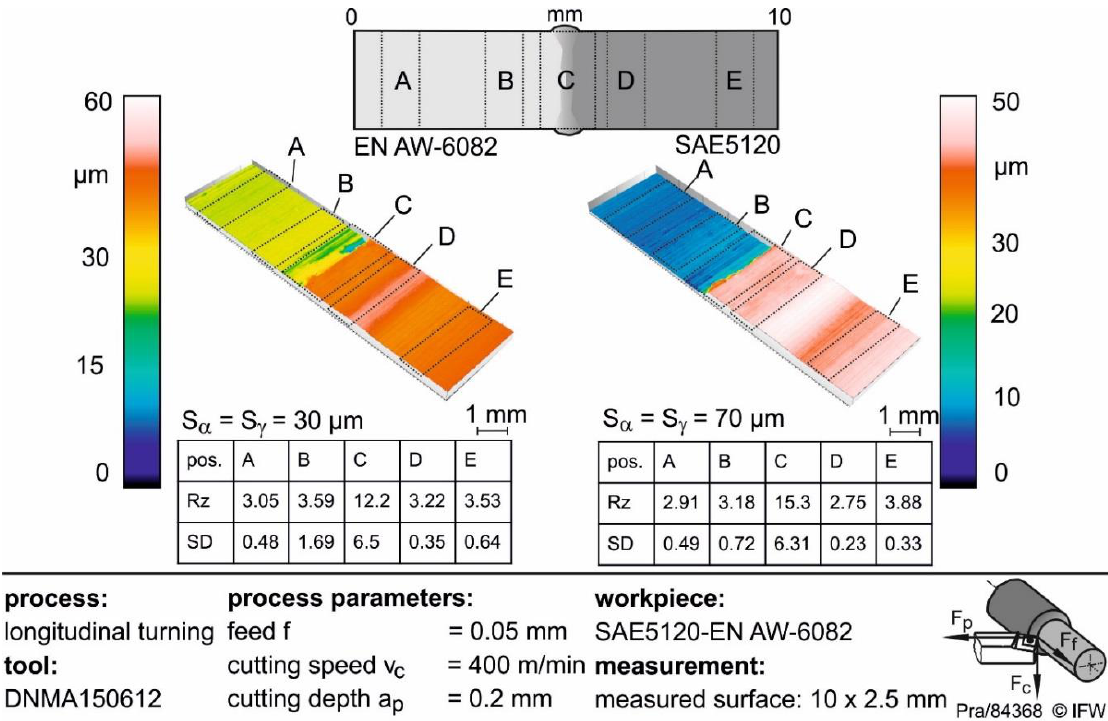
Figure 11. Influence of cutting edge geometry on surface roughness of turned steel-aluminium alloy welded shaft.